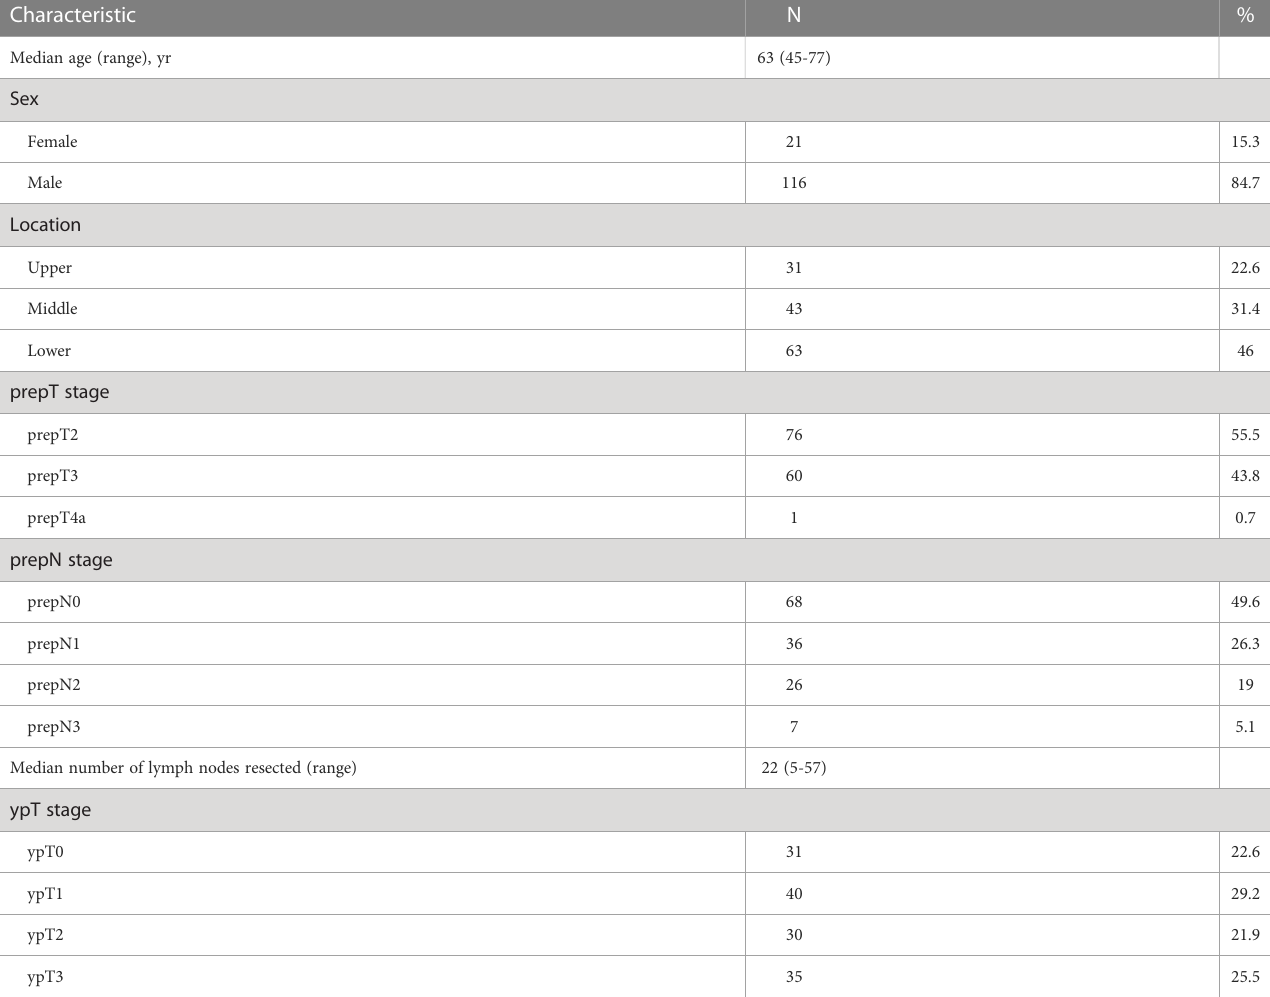
TABLE 1 Patient characteristics at